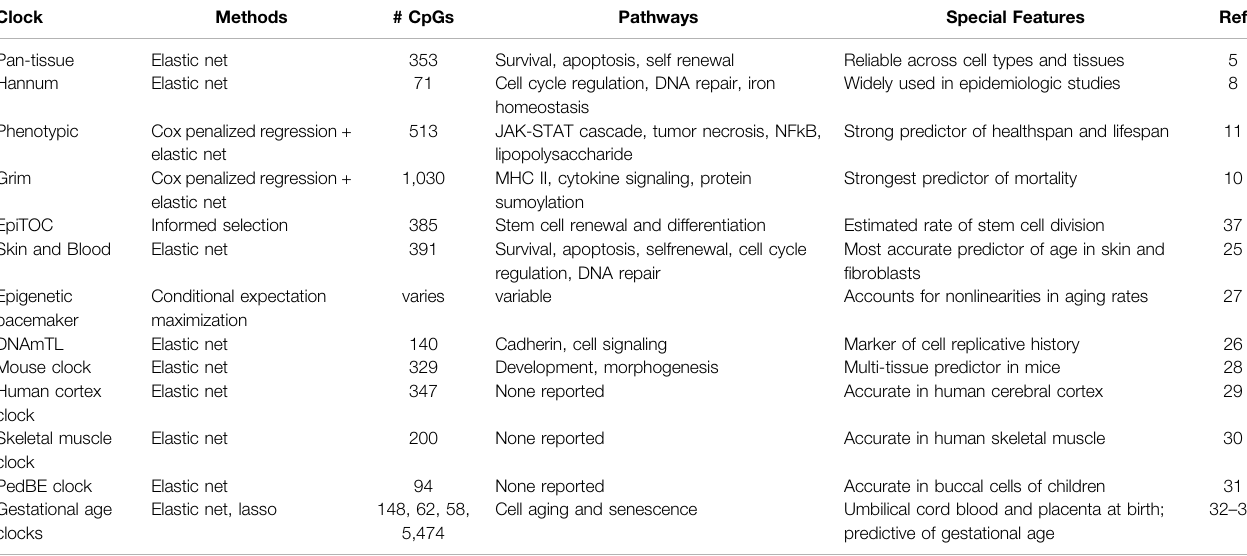
TABLE 1 | Features of epigenetic